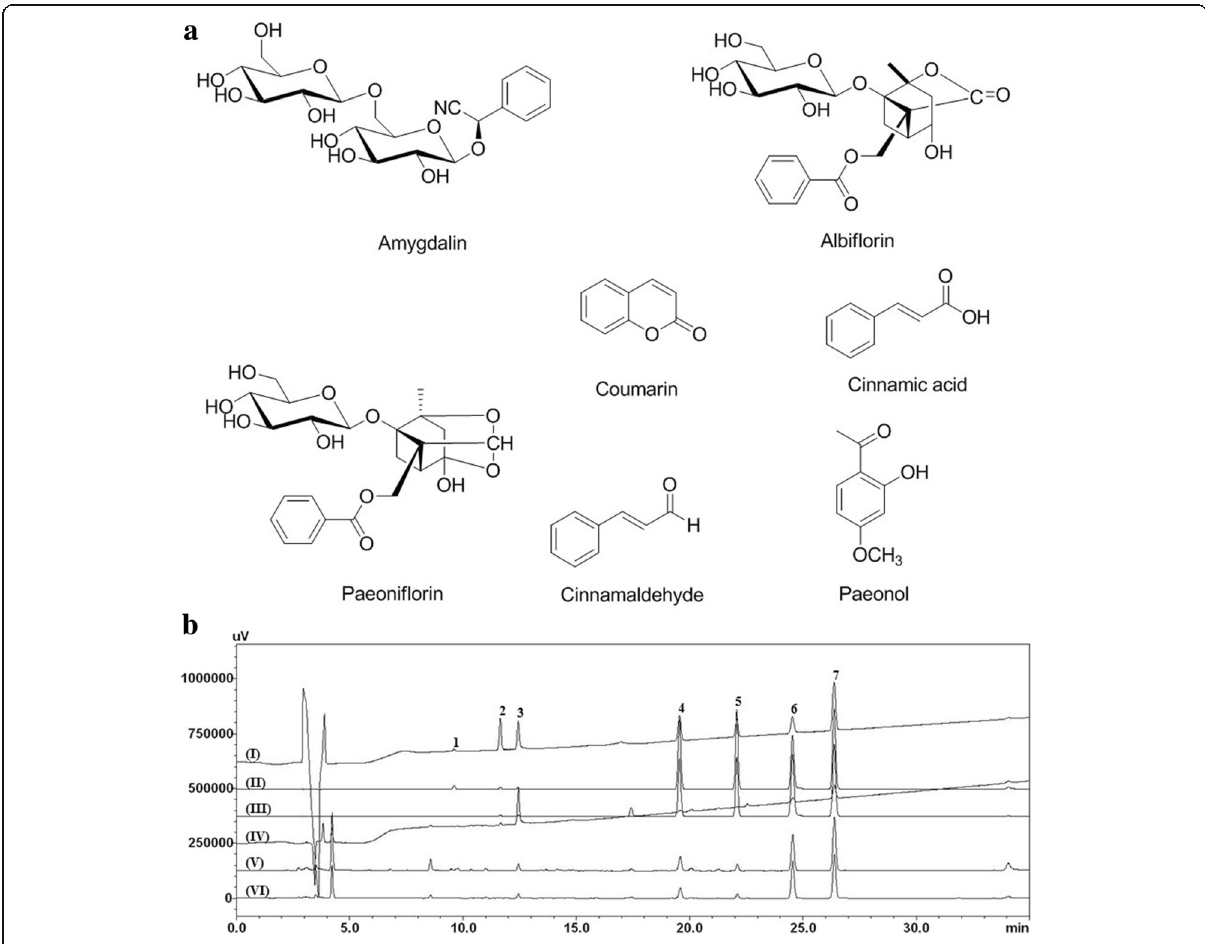
Fig. 1 HPLC chromatograms of ( a ) the reference standard mixture and ( b ) GJBRHE: 230 nm (I), 254 nm (II), and 280 nm